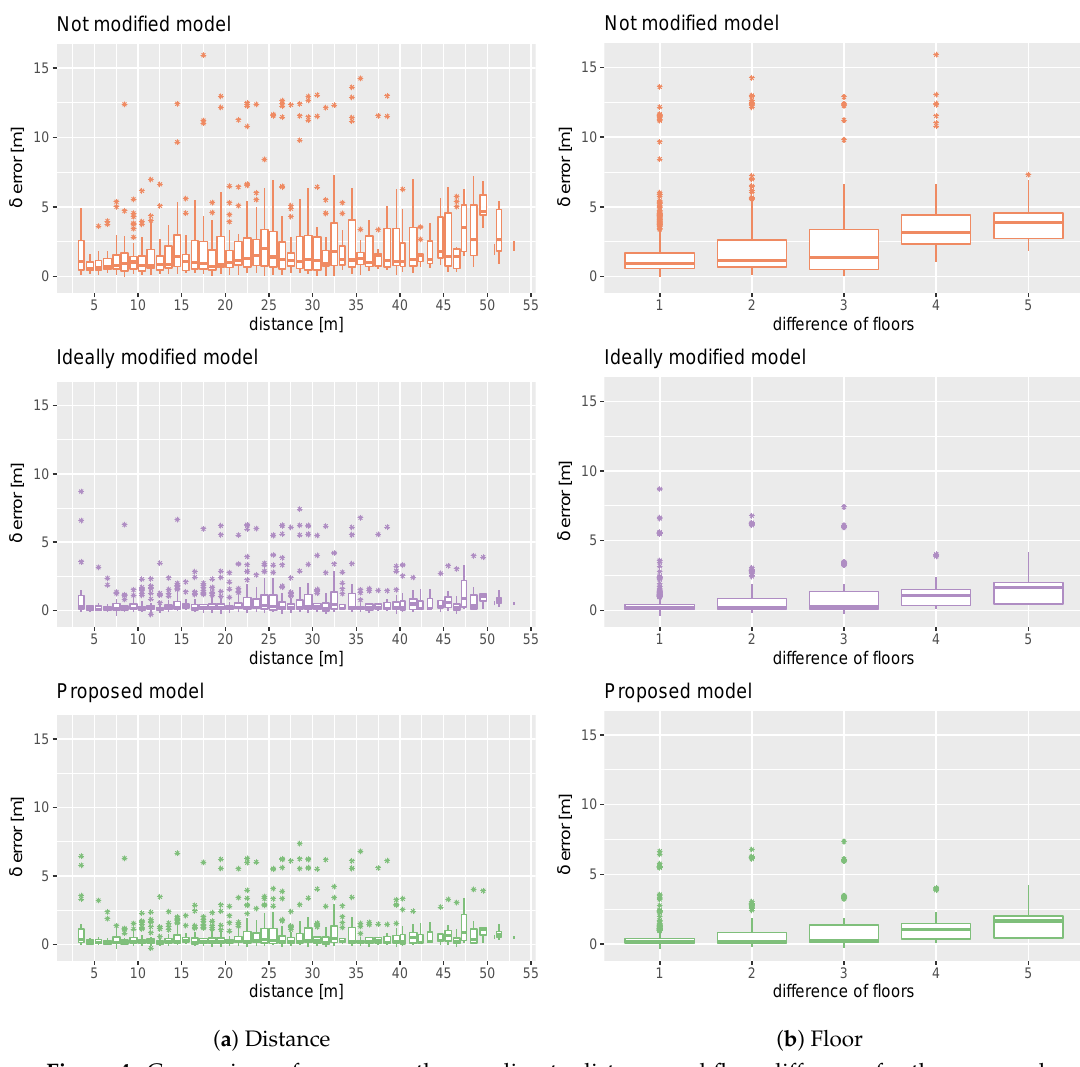
Figure 4. Comparison of error growth according to distance and floor difference for the proposed p L model ( m ), and the reference models without modification ( in Scenario 3.